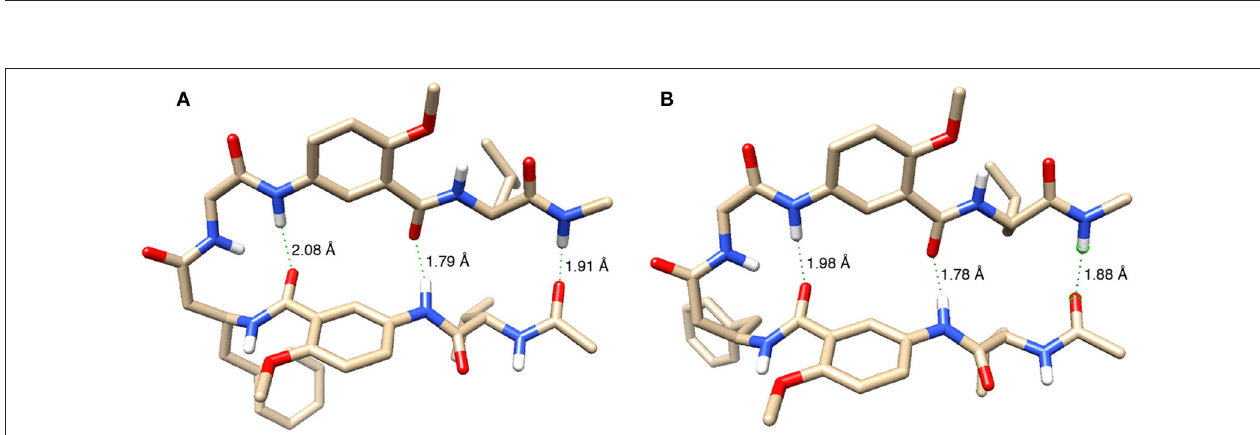
FIGURE 9 | Energy-minimized structures of the hairpin conformations of (A) 2a and (B) 2b . Except for amide hydrogens, all other hydrogen atoms are removed for clarity. Three N-H ••• O distances are indicated for each structure.